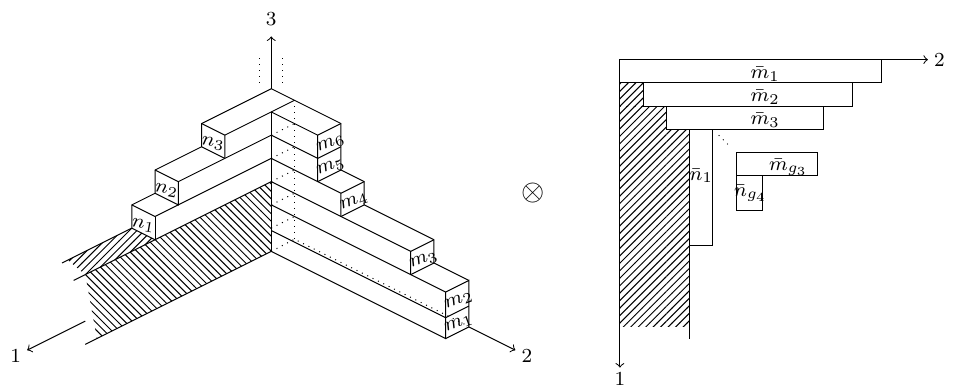
Figure 5 . The (cid:12)gure represents the state in the form of (3.5) with g 1 (cid:0) g 2 = g 4 (cid:0) g 3 < 0. The rows with in(cid:12)nite length and height g 2 (cid:0) g 1 are inserted. The above case corresponds to g 2 (cid:0) g 1 = 3. circumvent this complication by allowing the height or width of the intermediate Young diagram can be negative and suppose the shared asymptotic Young diagram appears in the (cid:12)xed